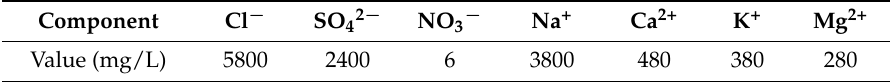
Table 4. Chemical composition of the processed mine water (as supplied by the distributor).